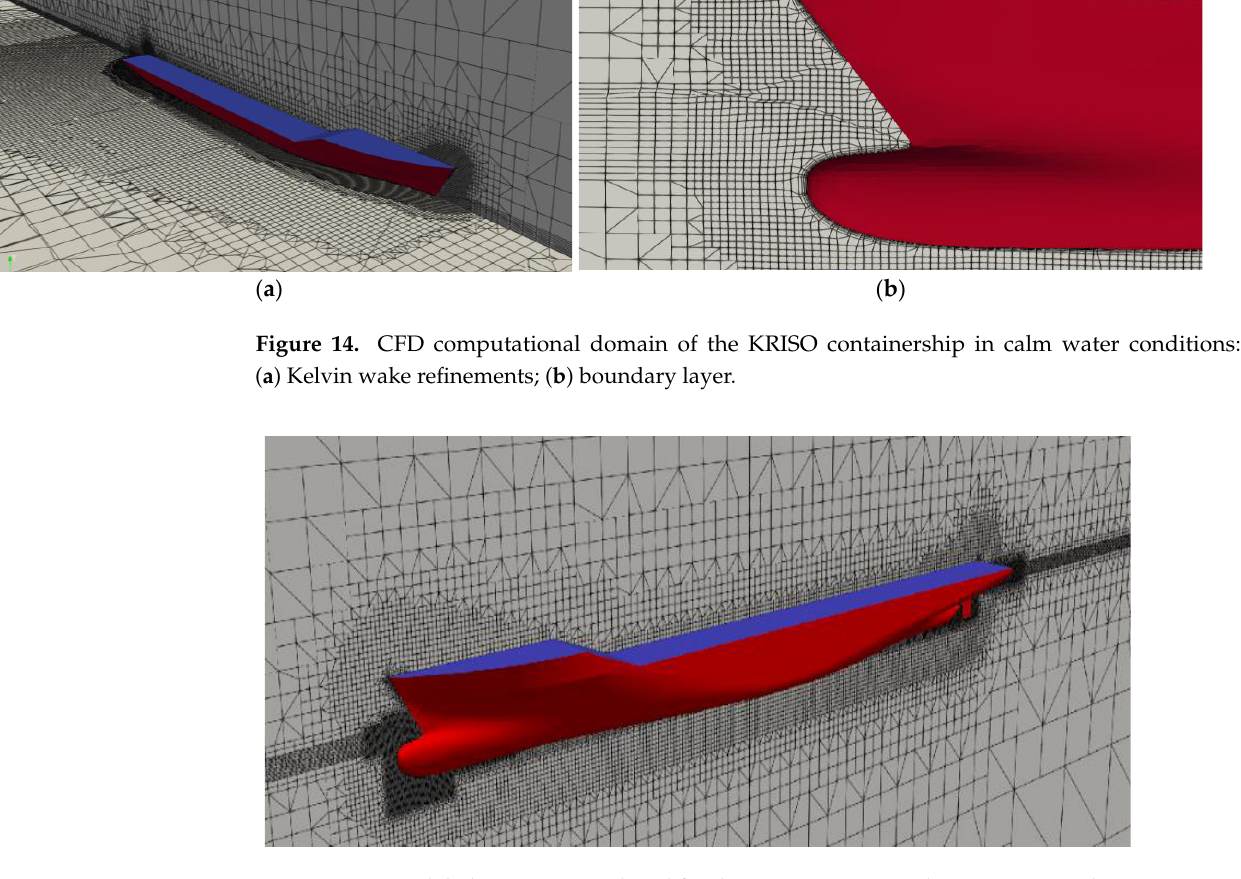
Figure 15. CFD global computational grid for the KRISO containership in wave